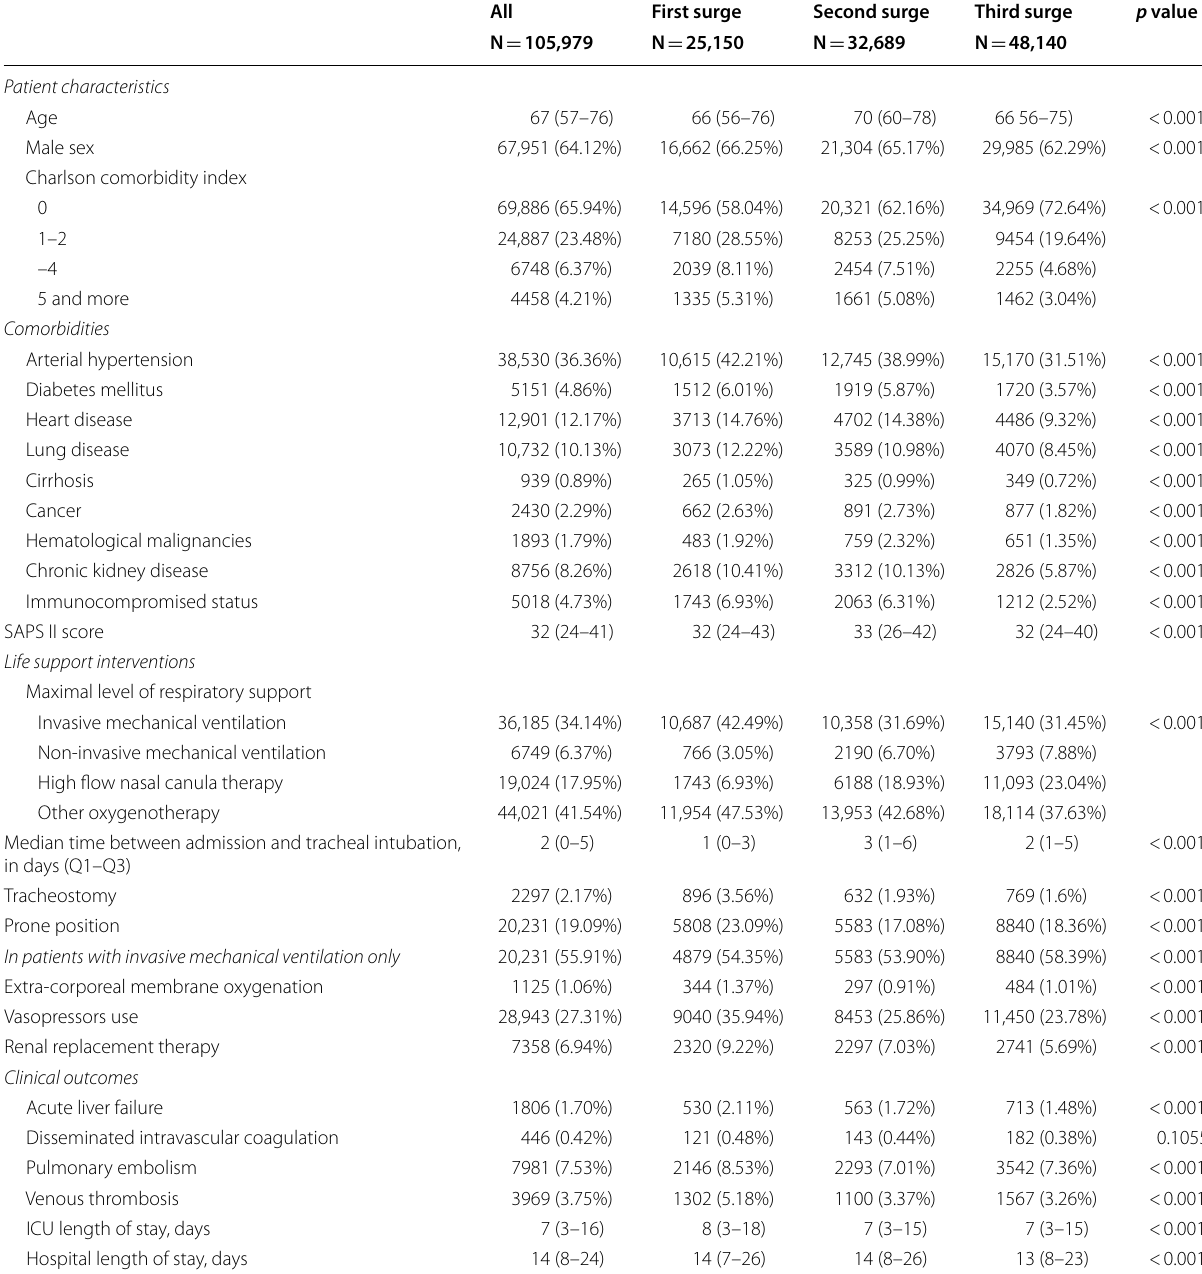
Table 1 Characteristics of the study population according to respective COVID-19 surge in